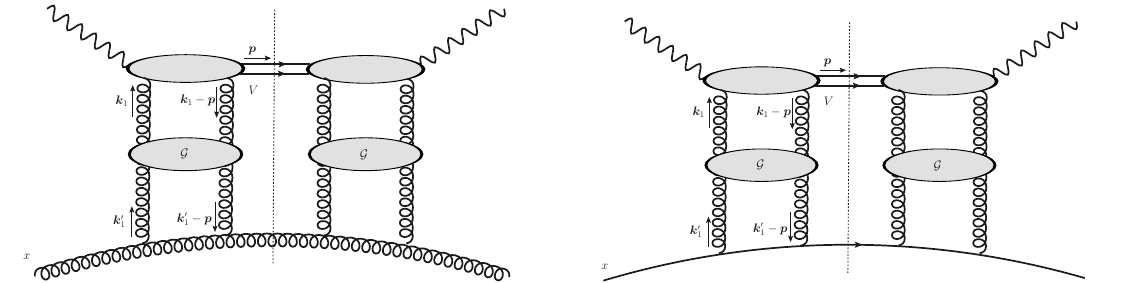
Figure 2 . The diagrams contributing to the cross section for di(cid:11)ractive vector meson V photopro- duction o(cid:11) a parton: a gluon (left) and a quark (right). The non-forward BFKL Green’s function is evolved along the rapidity gap between the vector meson and the proton G